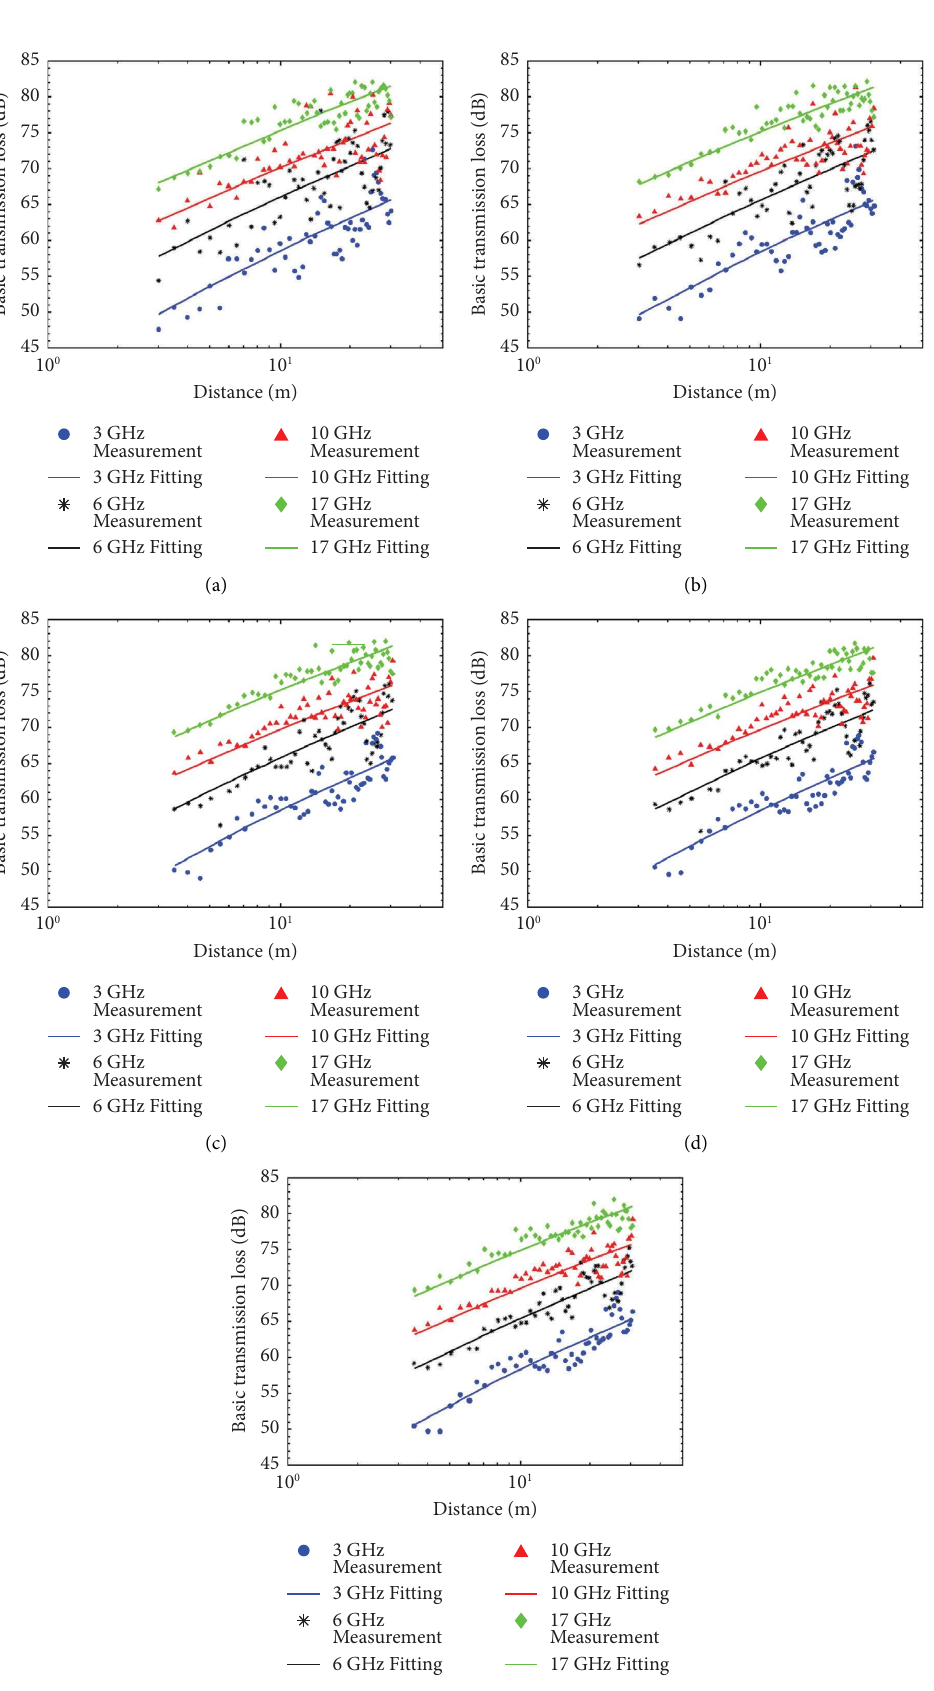
Figure 3: Measurement and ftting results of LOS. (a) 2 λ . (b) 4 λ . (c) 6 λ . (d) 8 λ . (e) 10 λ